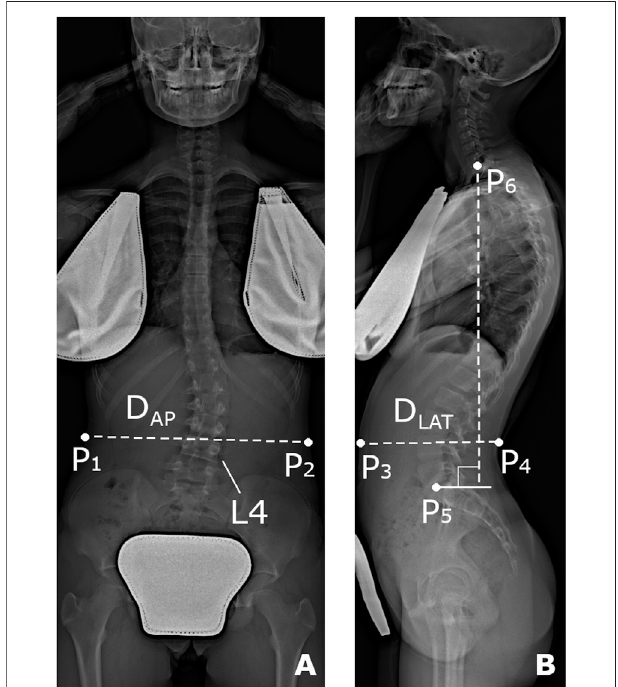
FIGURE A1 | Reference points (P1-P6) handpicked on the radiographic images in the coronal (A) and sagittal (B) plane for the prediction of subject ’ s weight and height. Anteroposterior diameter (D AP ) calculated as the distance between P1 and P2, lateral diameter (D LAT ) as that between P3 and P4, and vertical distance between L5S1 and C7T1 disc center (P5 and P6, respectively).